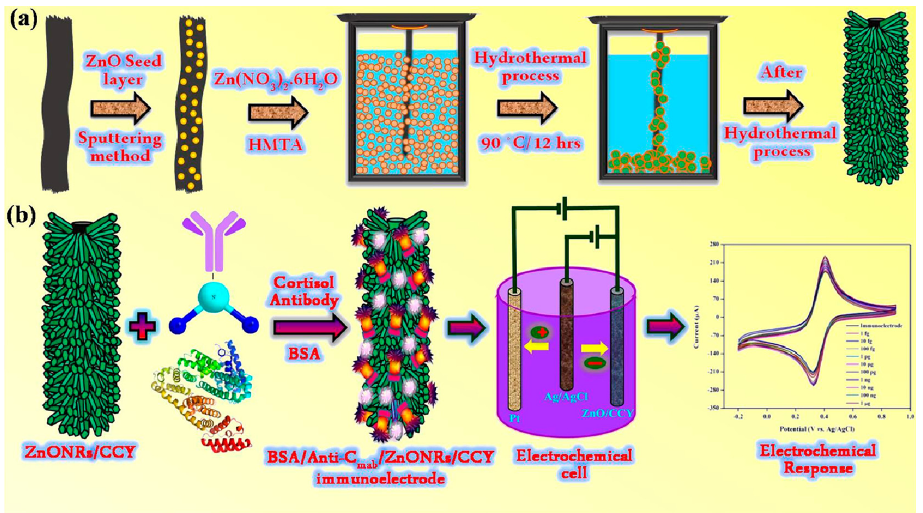
Figure 13. Schematic illustration of ( a ) insertion of ZnONRs on CCY and ( b ) step-by-step realization of an immunosensor with ZnONRs/CCY and electrochemical detection of cortisol (reproduced with permission from [73] . Copyright 2020 American Chemical Society).